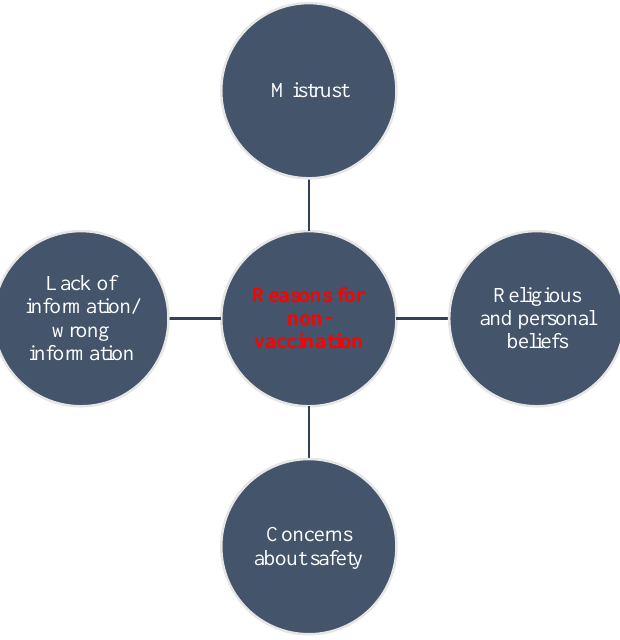
Figure 5. Emergent themes for reasons for rejecting the COVID-19 vaccines.